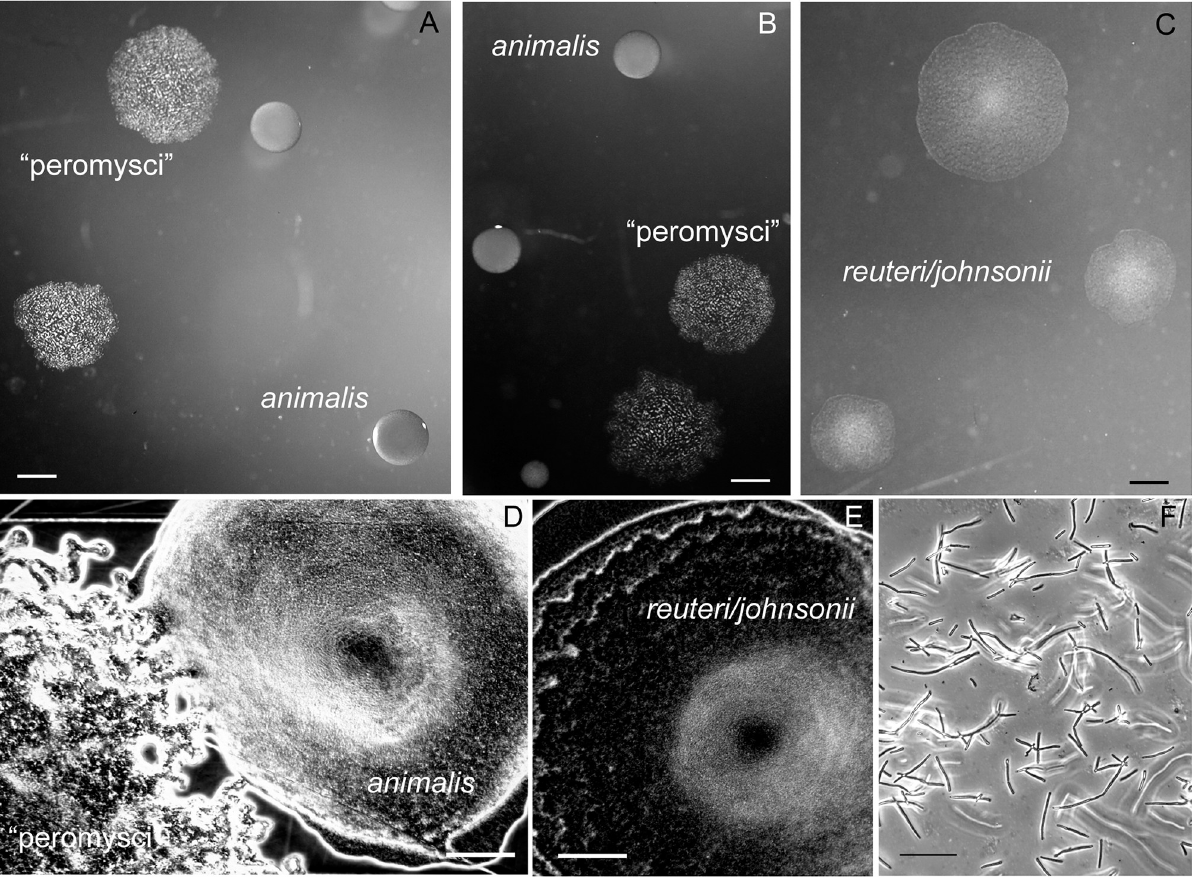
Fig 12. Colonies and cells of lactobacilli of the P . leucopus stomach and gut. Panels A-C show representative sizes and morphologies of colonies of “L. peromysci”, L . animalis , and the less distinguishable L . reuteri and L . johnsonii . Bars, 1 mm. Panels D and E show magnified view of colonies of “L. peromysci” and L . animalis (D) and that of L . reuteri and L . johnsonii (E). Bar, 100 μ m. Panel F, phase microscopy of wet mount of unconcentrated broth culture of “L. peromysci”. Bar, 10 μ